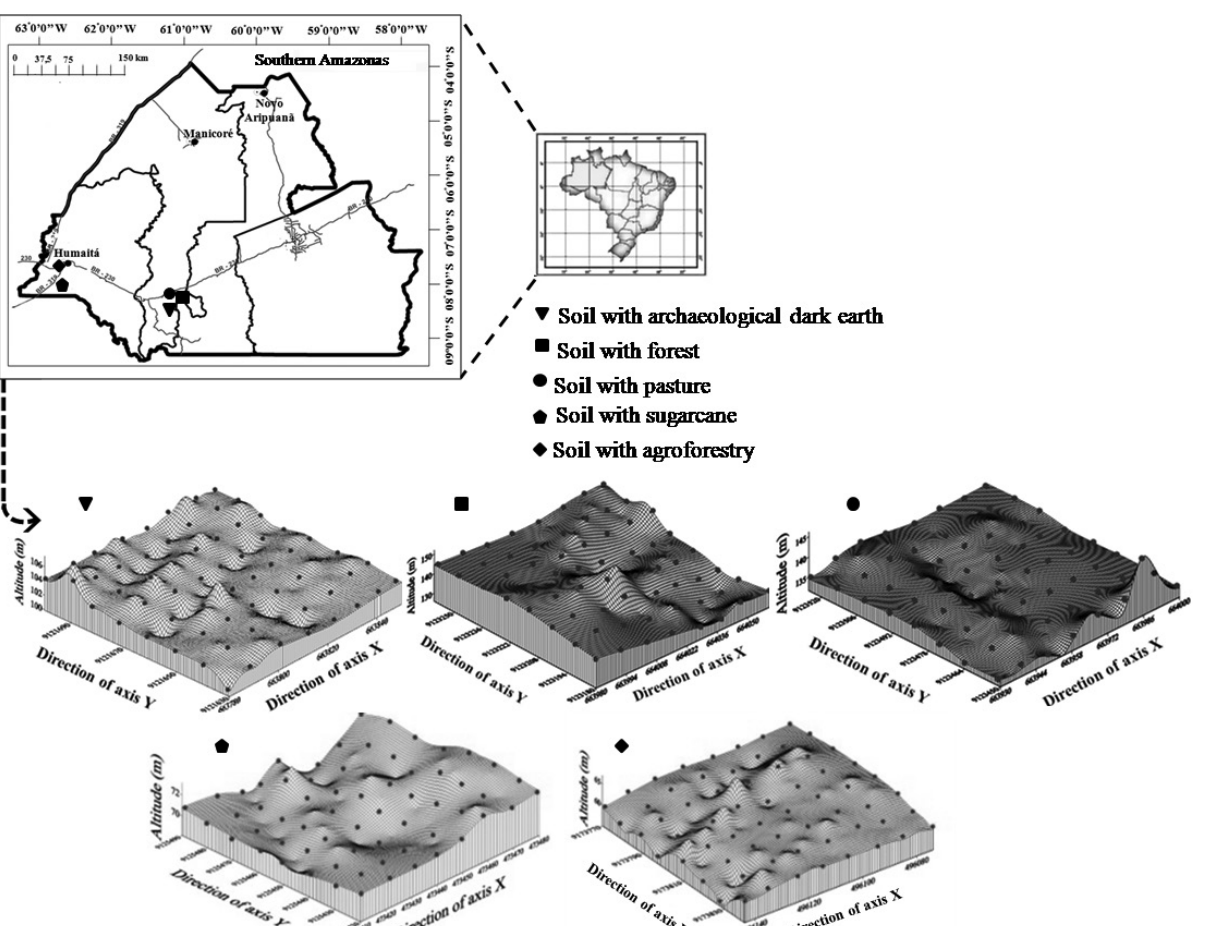
Figure 1. Area location and Digital Elevation Model (DEM) of the environments in southern